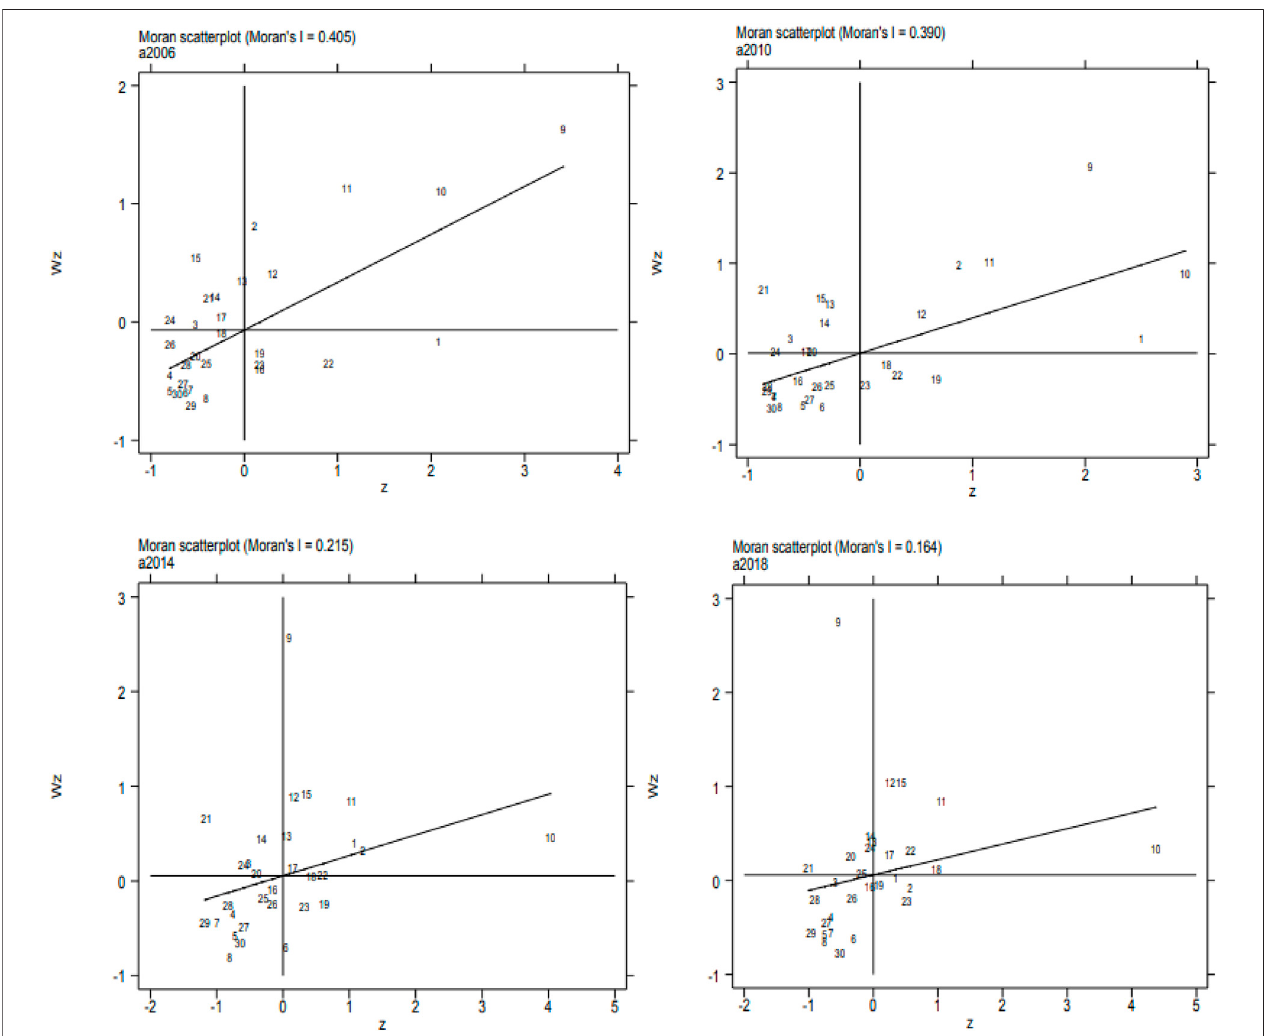
FIGURE 1 | Local Moran scatter chart of the local government debt level (2006, 2010, 2014, and 2018).